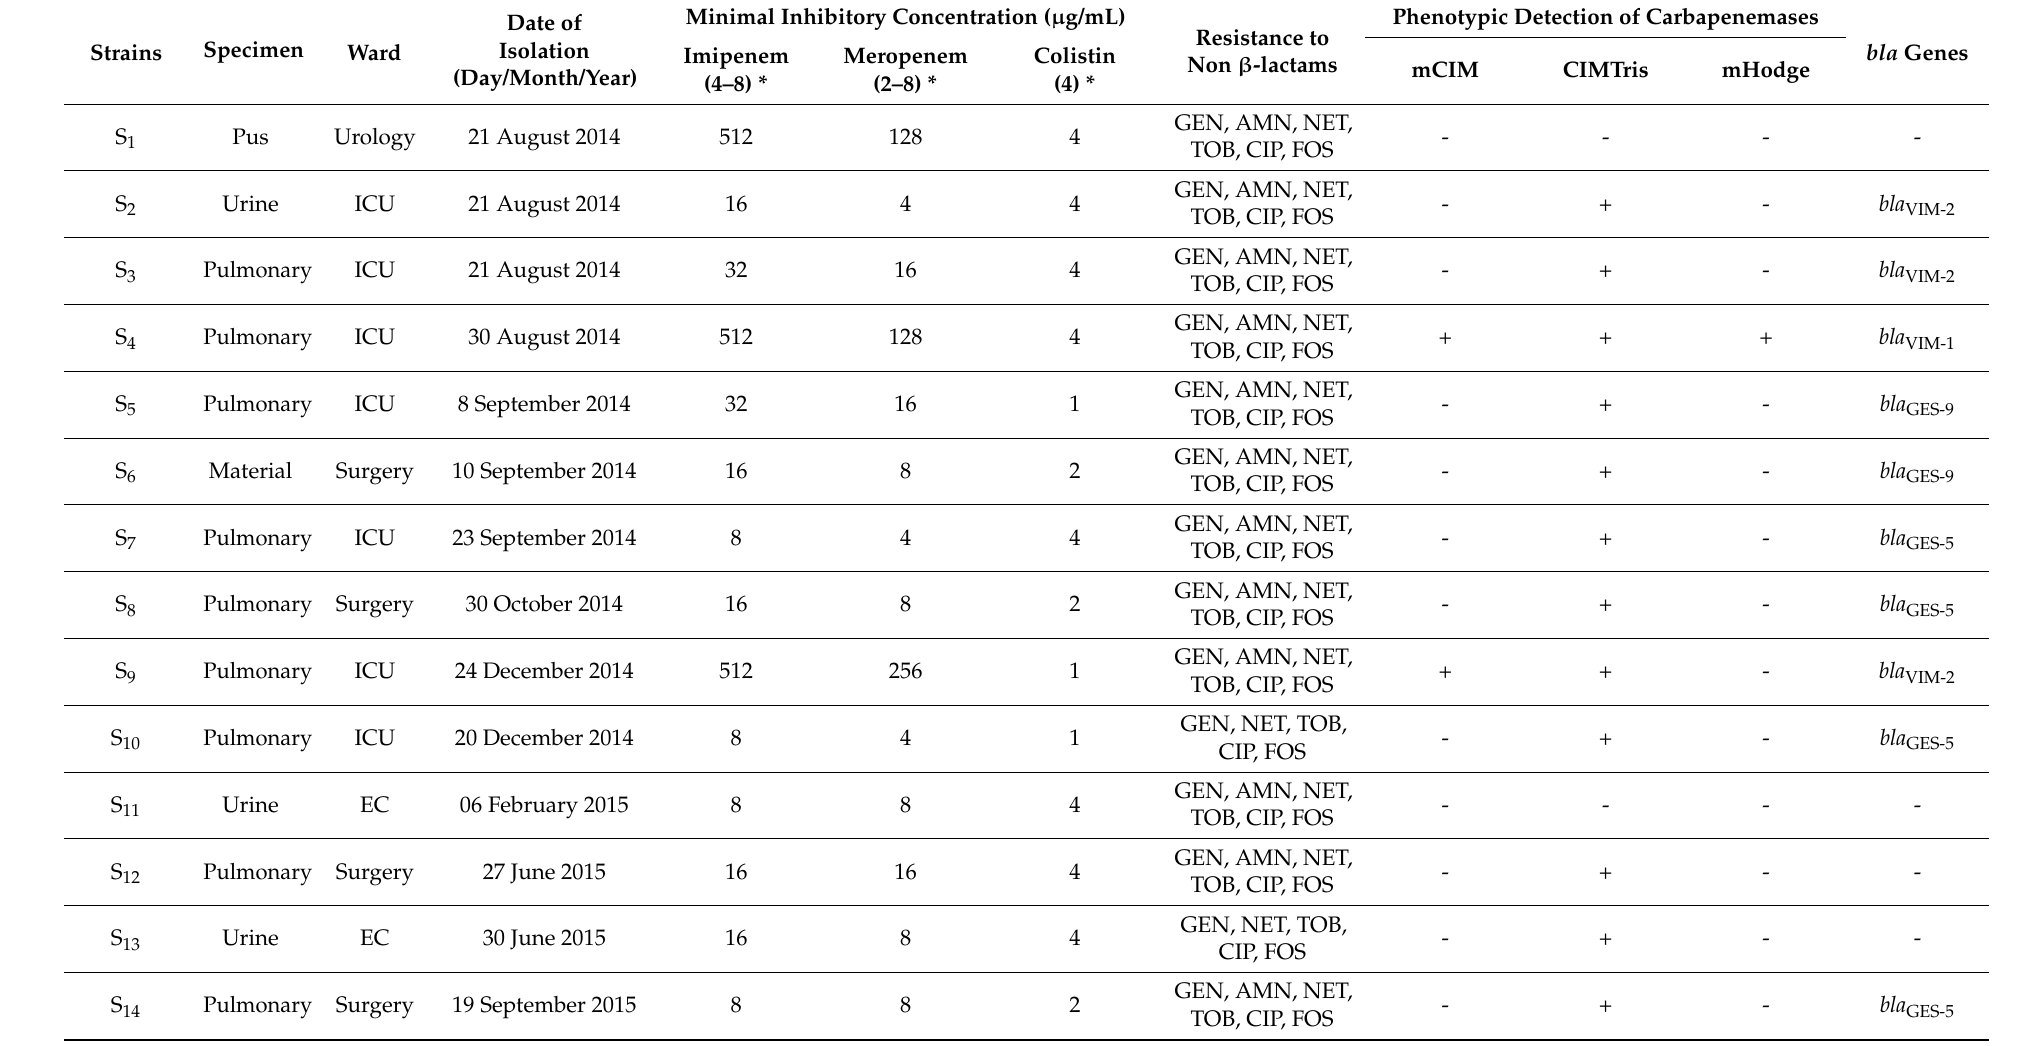
Table 2. Characteristics of imipenem- and ceftazidime-resistant P. aeruginosa isolates ( n =